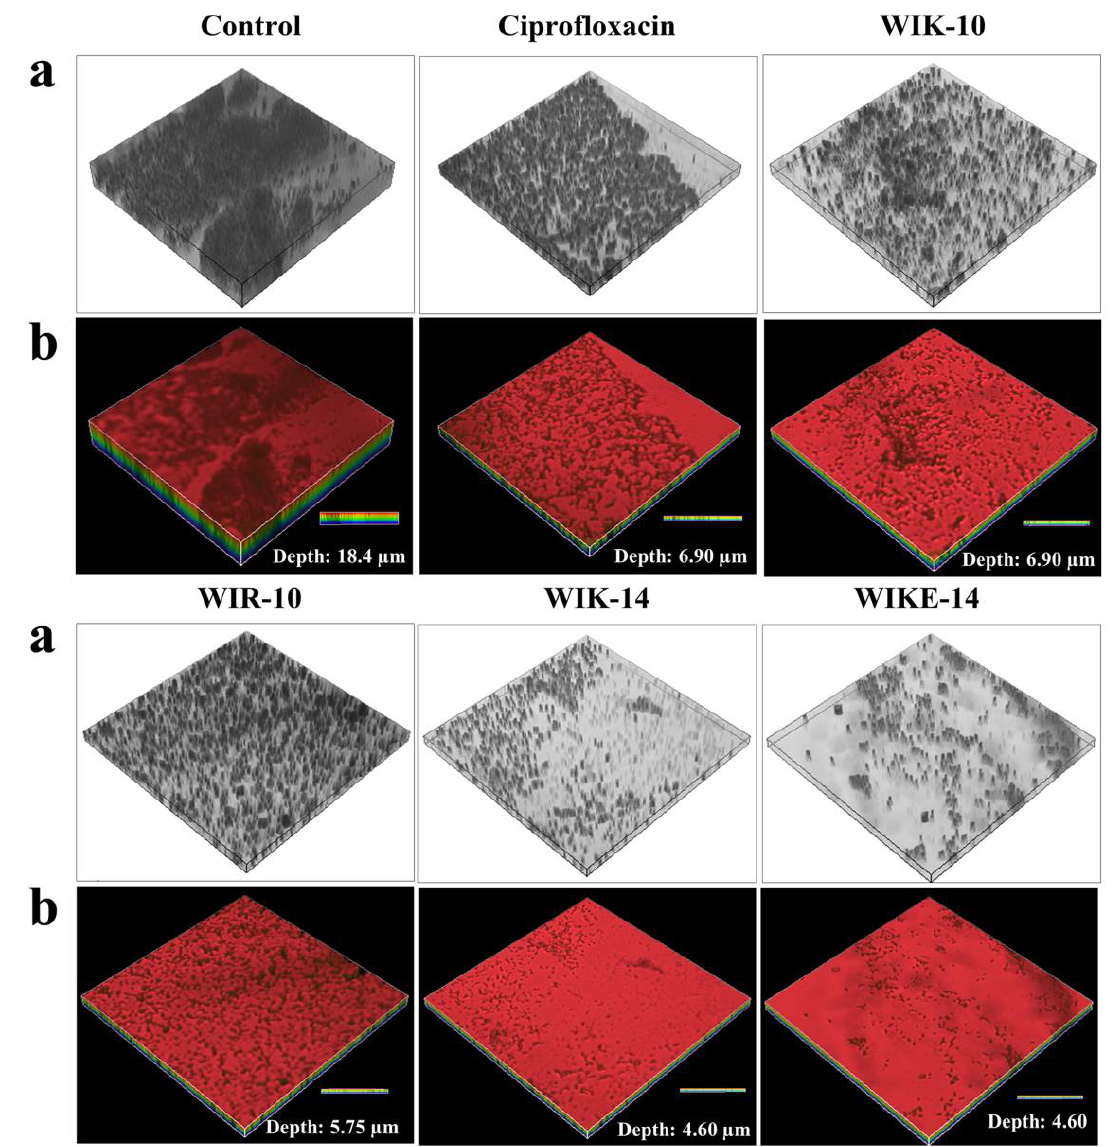
Figure 5. Reductive effects of ciprofloxacin and peptides on biofilm formed by P. aeruginosa DRPa 4007 strain using confocal laser scanning microscopy (CLSM). The biofilm reduction in the absence (control) or presence of ciprofloxacin (256 µM) and peptides (64 µM). Biofilm was stained using FilmTracer SYPRO Ruby biofilm matrix stain and observed in bright ( a ) and fluorescent ( b ) fields under CLSM.